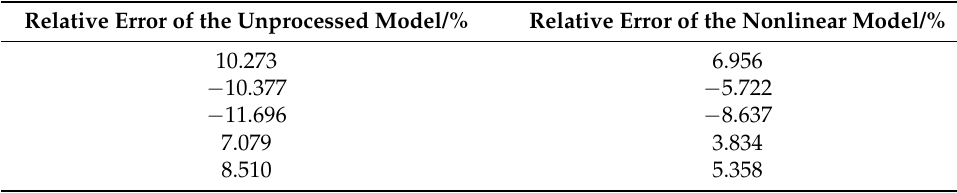
Table 4. Comparison of model prediction results.